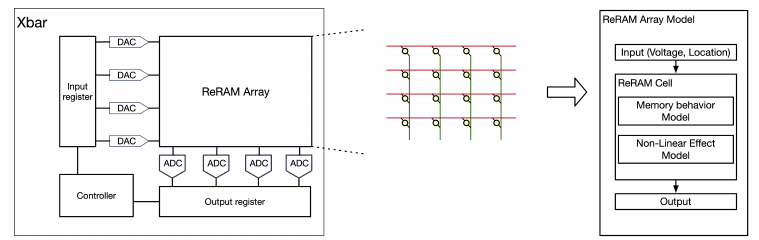
Figure 7. XBar architecture and ReRAM array